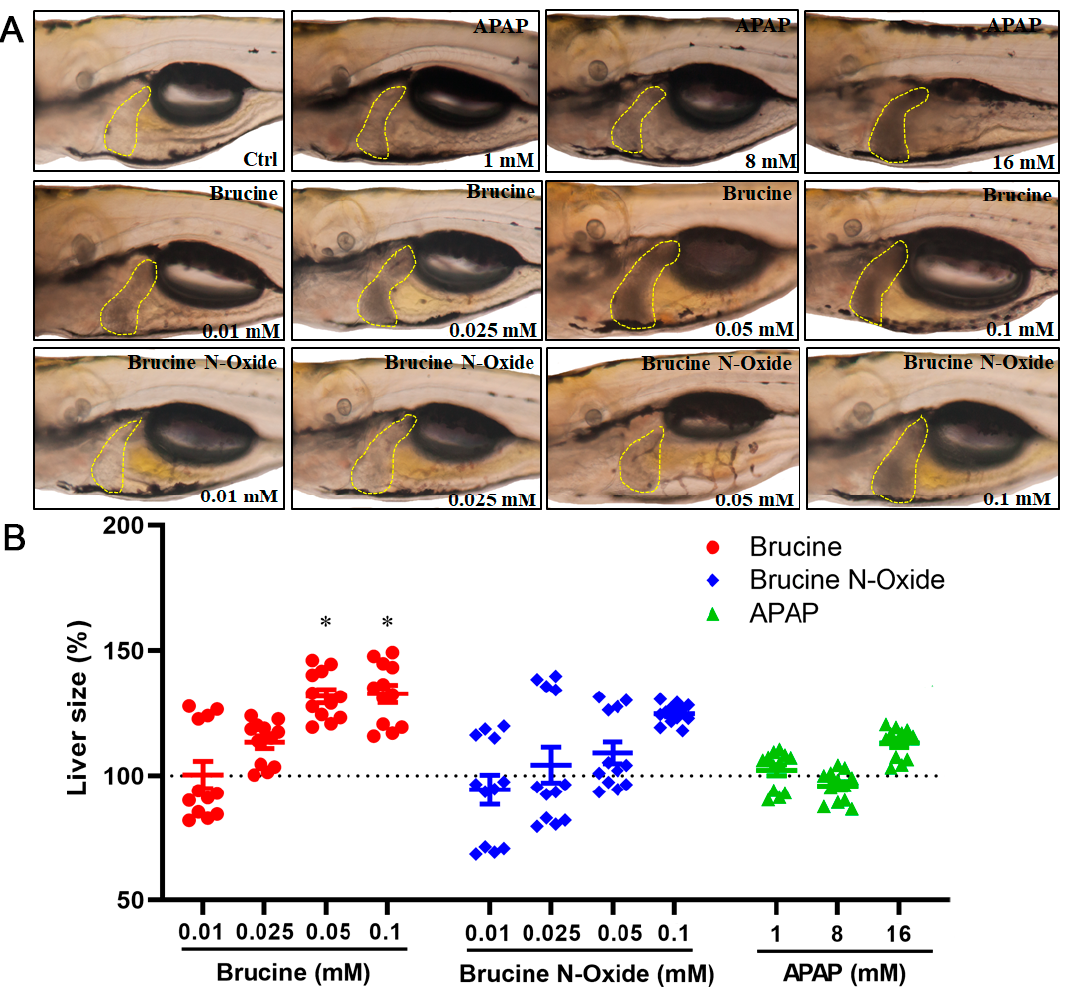
Figure 2. Effects of BRU and BNO on the liver phenotype of wild-type zebrafish. ( A ) Abnormal phenotypes caused by BRU, BNO and APAP on wild-type zebrafish, ( B ) Comparison of toxicity of BRU, BNO and APAP in wild-type zebrafish. Values represent the mean ± SEM (n = 20), * p < 0.05 .